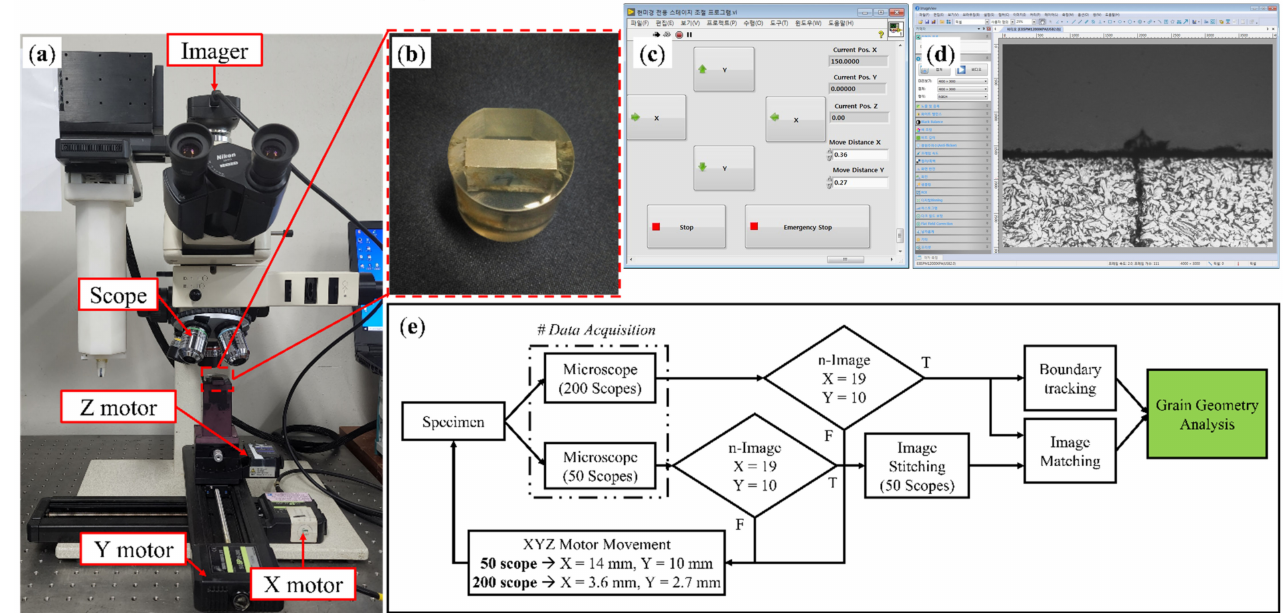
Figure 2. Experimental setup for data acquisition process and geometric analysis of grain boundary using integrated image processing toolsets: ( a ) optical microscopy setup, ( b ) mounted specimen, and ( c ) X-Y-Z stage motor controller based on LabVIEW, ( d ) microscope user interface, ( e ) experimental flow